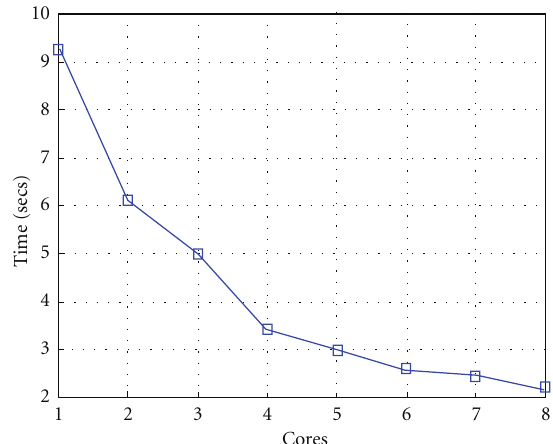
Figure 9: Test 1: Algorithm SI: Total execution time versus the number of cores. Δ τ = 0 . 16. 3 scale